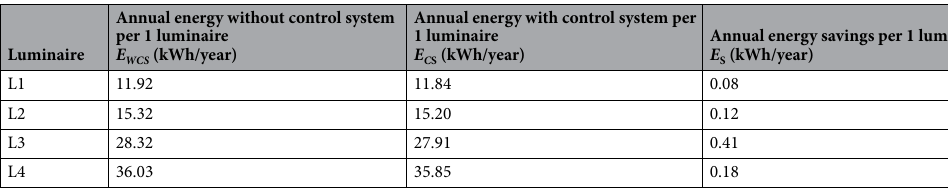
Table 5. Annual electricity consumption savings per 1 luminaire.